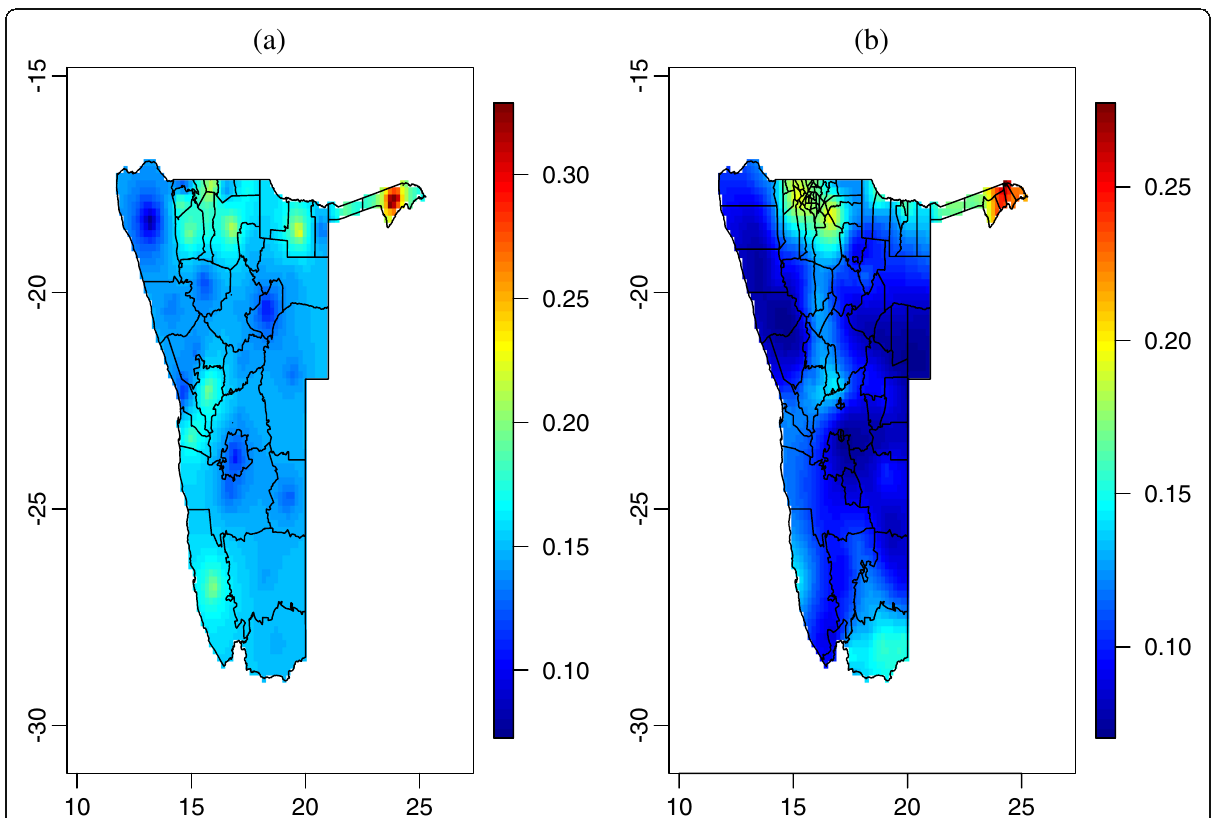
Fig. 3 Estimated HIV prevalence using separate models: ( a ) HIV prevalence estimates from 2014 NHSS data; ( b ) HIV prevalence estimates from 2013 NDHS